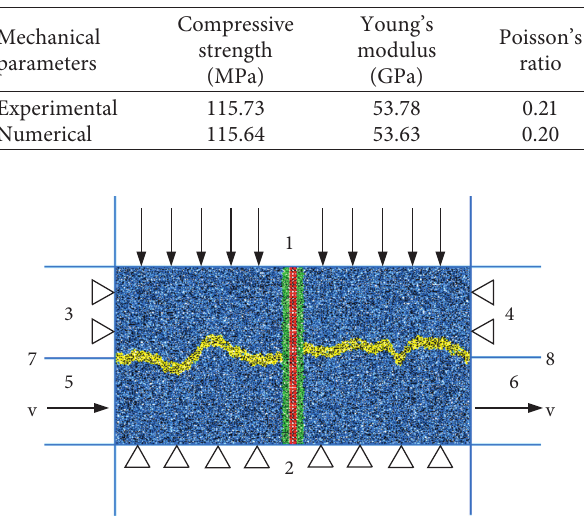
Figure 2: The curve of uniaxial compression. Table 2: Mechanical parameters of marble.